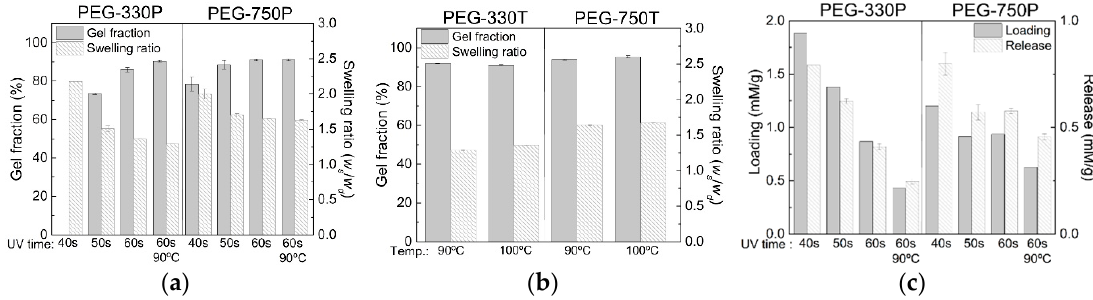
Figure 7. ( a , b ) Gel fraction and swelling ratio data, and ( c ) Rh-B loading and release amounts of PEG-